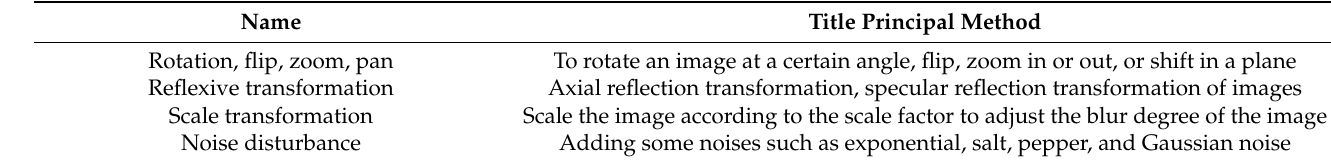
Table 7. Some common data enhancement